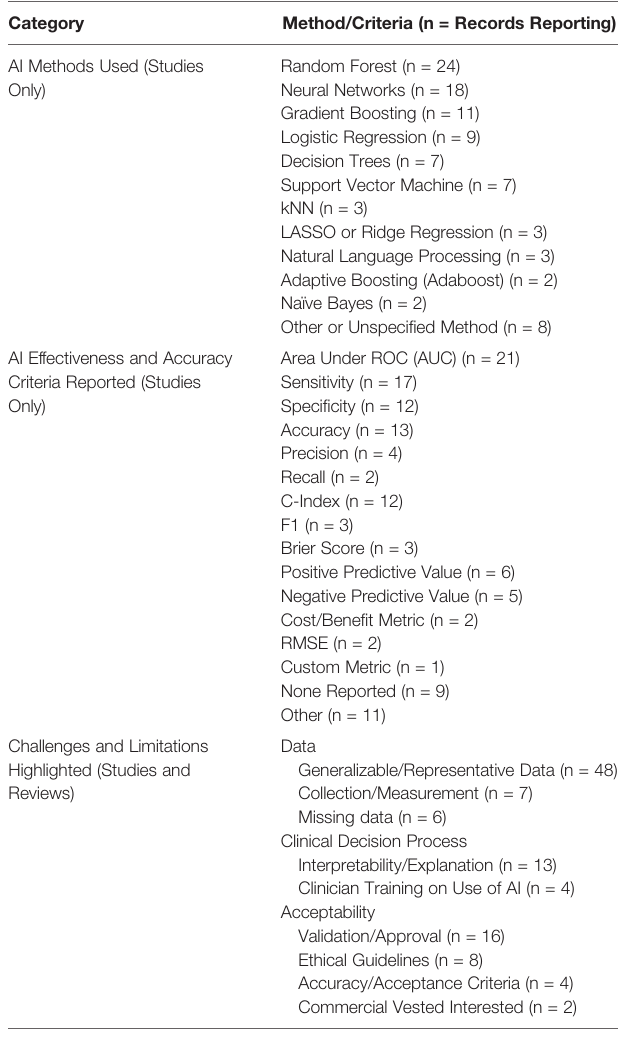
TABLE 1 | AI Methods, Effectiveness and Accuracy Criteria, and Challenges identi fi ed by studies in review. Category Method/Criteria (n = Records